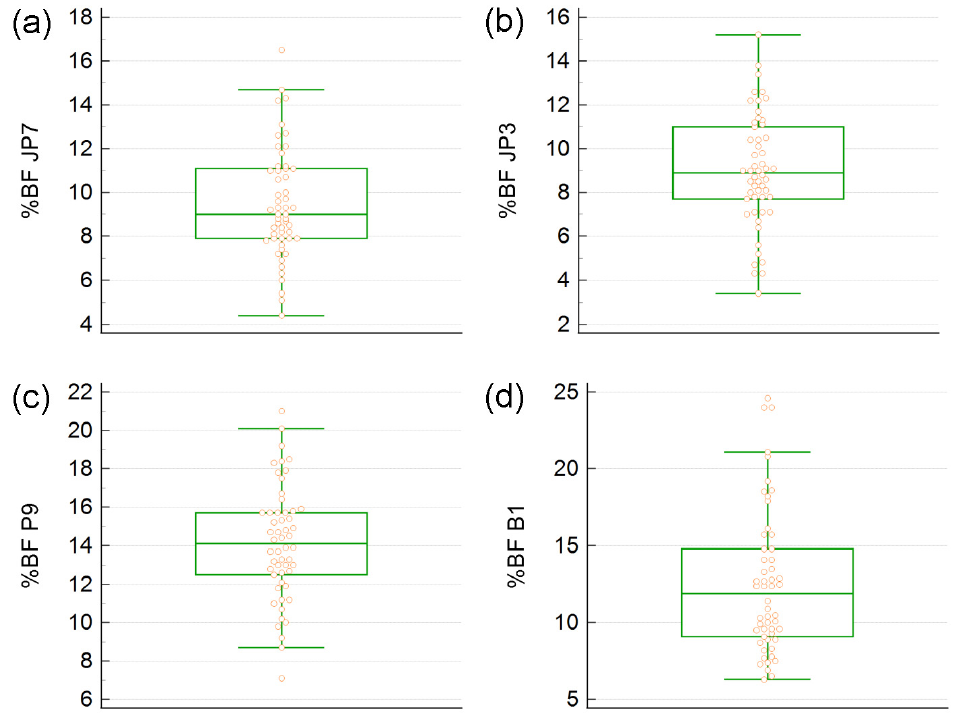
Figure 1. Box plots of body fat percentage (%BF) assessed by A-mode ultrasound using four different prediction formulas implemented in the BodyViewProFit software shipped with the BodyMetrix instrument: ( a ) the 7-sites Jackson–Pollock (JP7) formula, ( b ) the 3-sites Jackson–Pollock (JP3) formula, ( c ) the 9-sites Parrillo (P9) formula, and ( d ) the 1-point biceps (B1) formula. In each plot, the lower edge of the box depicts the first quartile (Q 1 ); the horizontal line within the box represents the median, or the second quartile (Q 2 ); and the upper edge of the box depicts the third quartile (Q 3 ). The points beyond the whiskers are considered outliers.